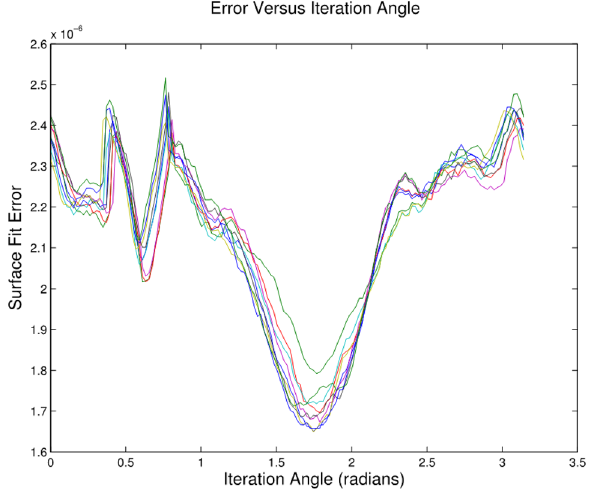
Fig. 7 Fracture surface fit error versus iteration angle showing one main hydraulic fracture and other possible secondary fracture orien- tations. The plot shows all nine origin locations that were used (nine points surrounding a circular wellbore). The well-developed error minimum at approximately 1.7 radians in the roll direction for this particular lowest error pitch direction is shown